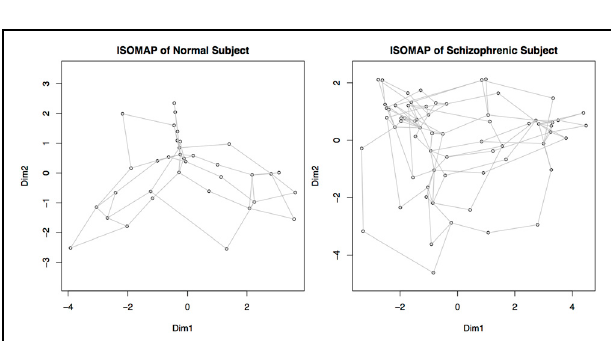
FIGURE 6 | Graphs representing connectivity of two subjects, obtained by converting the distance matrices for each subject into a structure where each node represents a component, and the distance between nodes represents the connectivity or similarity of their behaviors. Nodes close together demonstrate a higher functional connectivity measure. This map is obtained by recalculating the connectivity matrices using geodesic distances, and then embedding the points in a two dimensional space for plotting. Dim 1 and Dim 2 represent the weightings on the two primary dimensions, similar to multi-dimensional